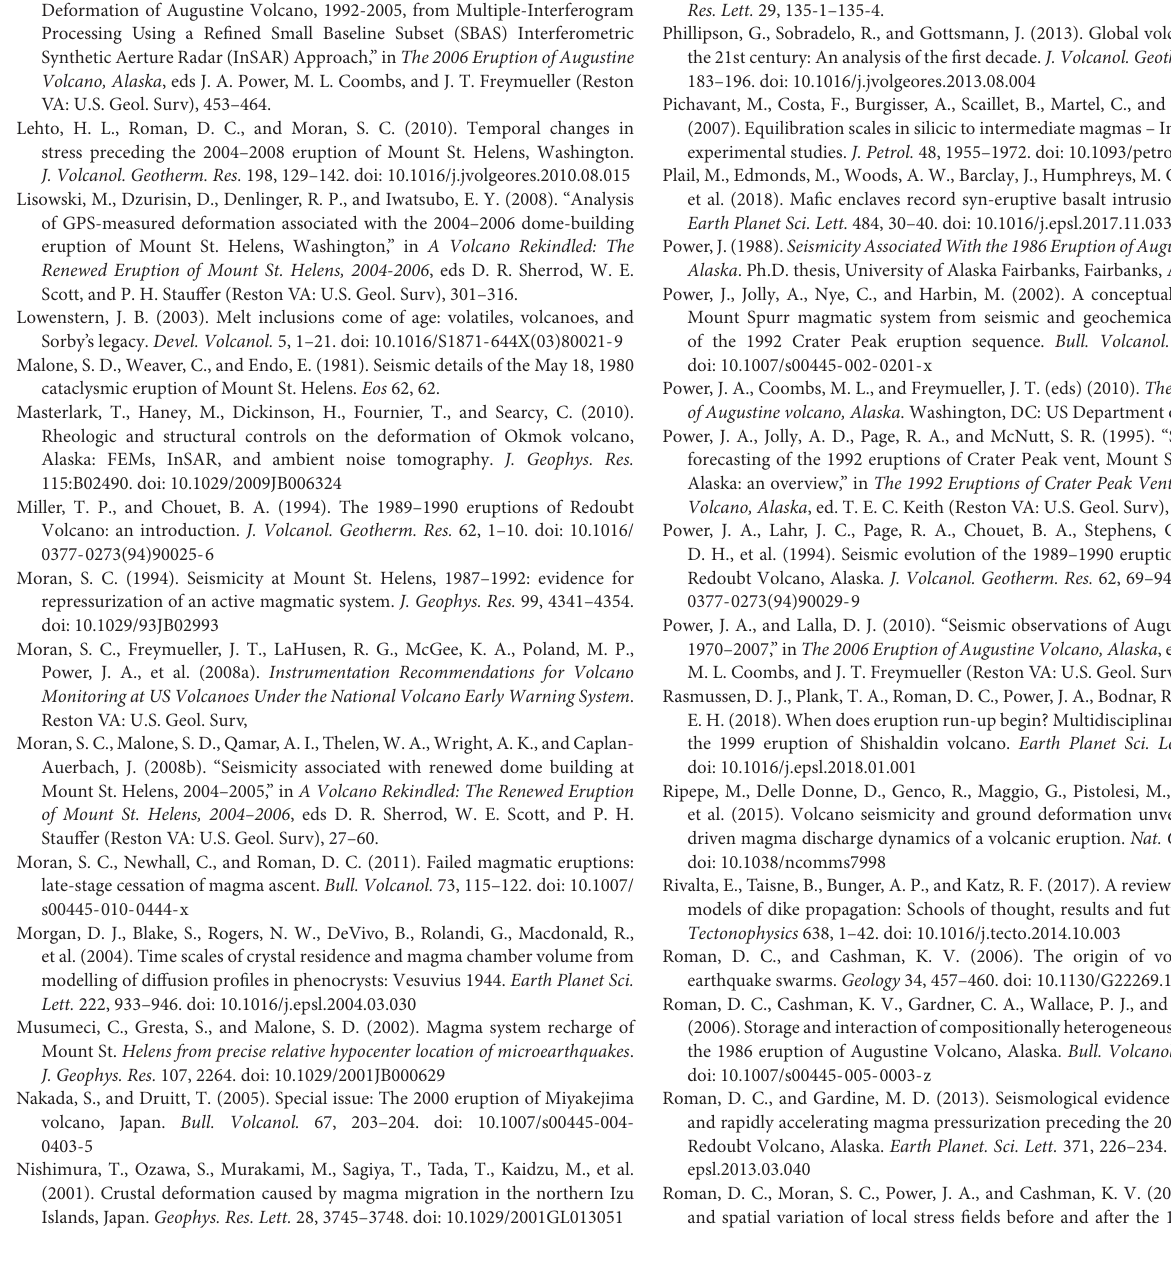
Frontiers in Earth Science |